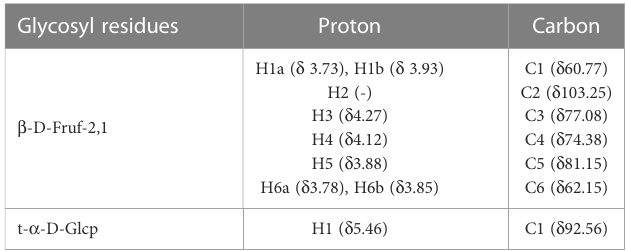
TABLE 2 Assignments of the 1 H and 13 C NMR spectra of PGNP based on an analysis of the COSY, HSQC, and HMBC spectra. Glycosyl residues Proton Carbon